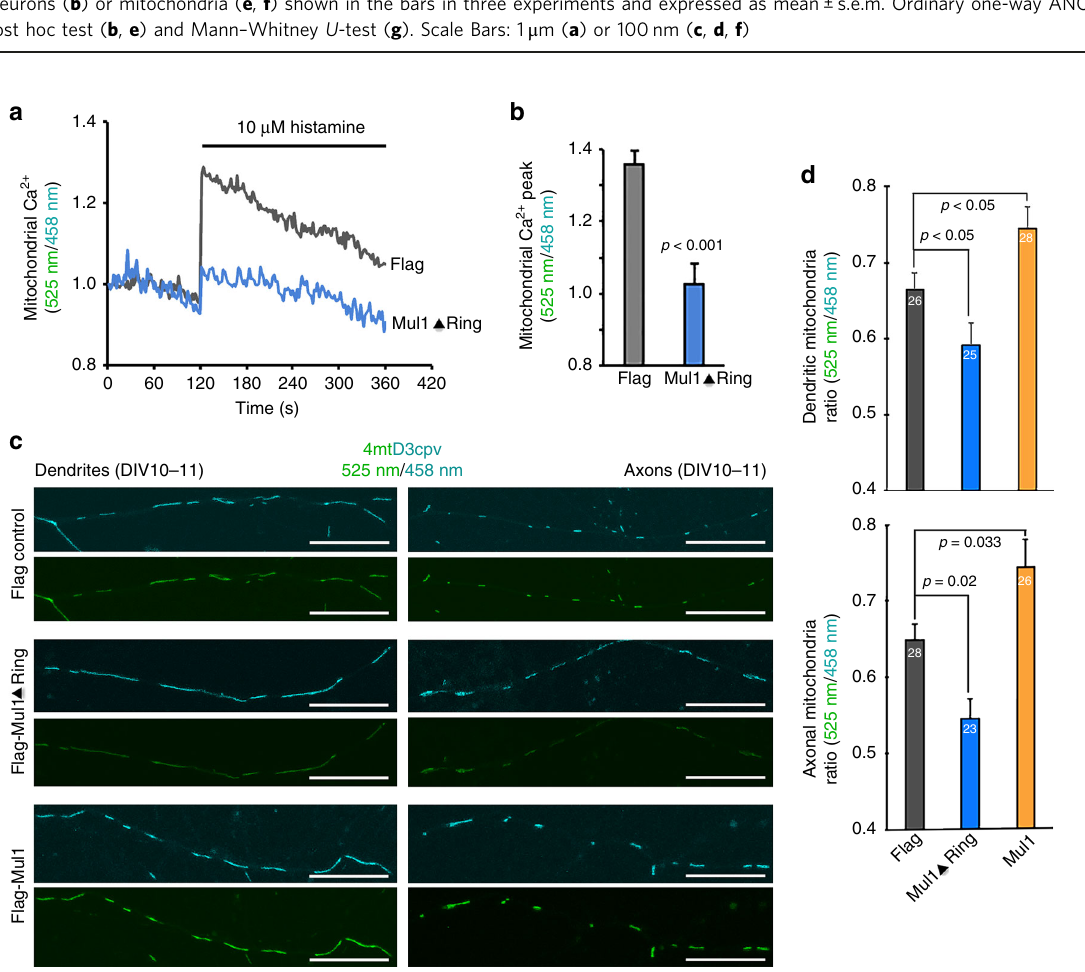
Fig. 6 Mul1 de fi ciency reduces mitochondrial Ca 2 + uptake from the ER. a , b Representative traces and quantitative analysis of the average maximal Ca 2 + peak showing impaired mitochondrial Ca 2 + uptake from the ER in Mul1-de fi cient neurons. Cortical neurons were co-transfected at DIV7-8 with pcDNA- 4mtD3cpv and Flag or Flag-Mul1 Δ Ring, followed by live imaging at DIV10-11. The emission spectra of the ratiometric probe (525 nm/458nm) were obtained by exciting 405 nm following stimulation with 10 μ M histamine. c , d Reduced Ca 2 + load in both axonal and dendritic mitochondria in Mul1- de fi cient neurons. The pseudo colors cyan (458 nm) and green (525 nm) represent the emission spectra of the ratiometric probe when excited with 405 nm. The images were captured from dendritic and axonal compartments as indicated. The mitochondrial Ca 2 + load was expressed as a ratio (525 nm/458 nm). Note that expressing Mul1 Δ Ring signi fi cantly reduces the ratio while expressing Mul1 enhances the ratio. Data were analyzed from 2 to 3 live neurons per fi eld with 4 fi elds per experiment ( b ), or total number of fi xed neurons indicated in the bars ( d ) in three experiments and expressed as mean ± s.e.m. Unpaired Student ’ s t -test was used for comparing two groups and Ordinary one-way ANOVA with Dunnett multiple comparison test for multiple comparisons. Scale Bars: 10 μ